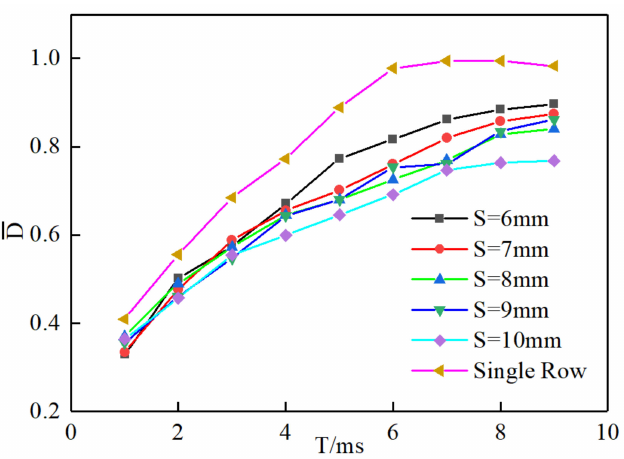
Figure 19. Evolution of